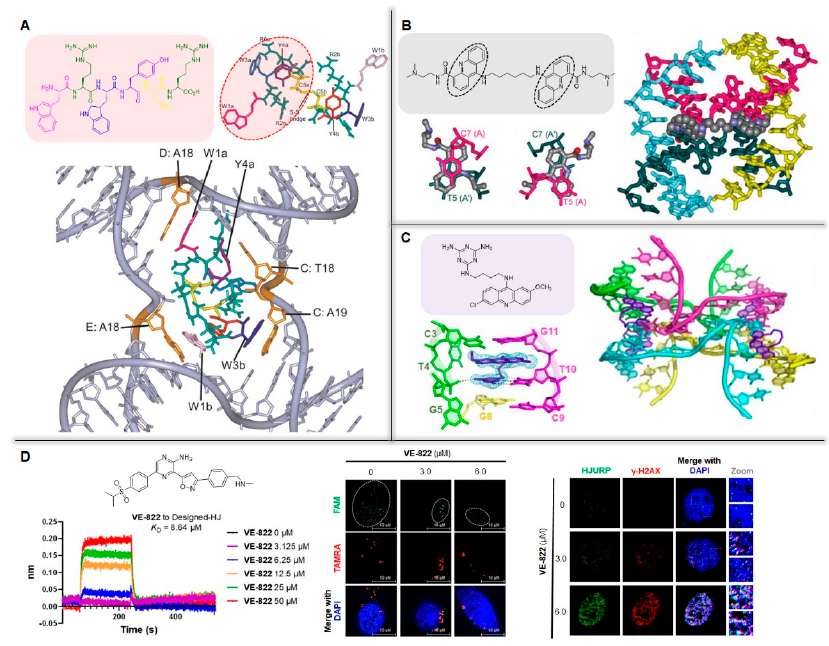
Figure 4. Structures, binding modes and bioactivities of HJ ligands. ( A ) Monomeric and dimeric struc- tures of hexapeptide WRWYCR and its predicted binding model with HJ [94]. ( B ) Chemical structure of dimeric acridine C6, along with the crystal structure with HJ (PDB: 2GWA) [17]. ( C ) Chemical structure of acridine derivative Z1 and its crystal structure with HJ (PDB: 6M5J) [97]. ( D ) Structure of HJ-ligand VE-822 and its binding affinity to HJ using Bio-Layer Interferometry assay ( left ), and VE-822 promote the assembly of transfected HJ in cells using fluorescence quenching assay ( middle ) and induce HJ-stabilized damage ( right )